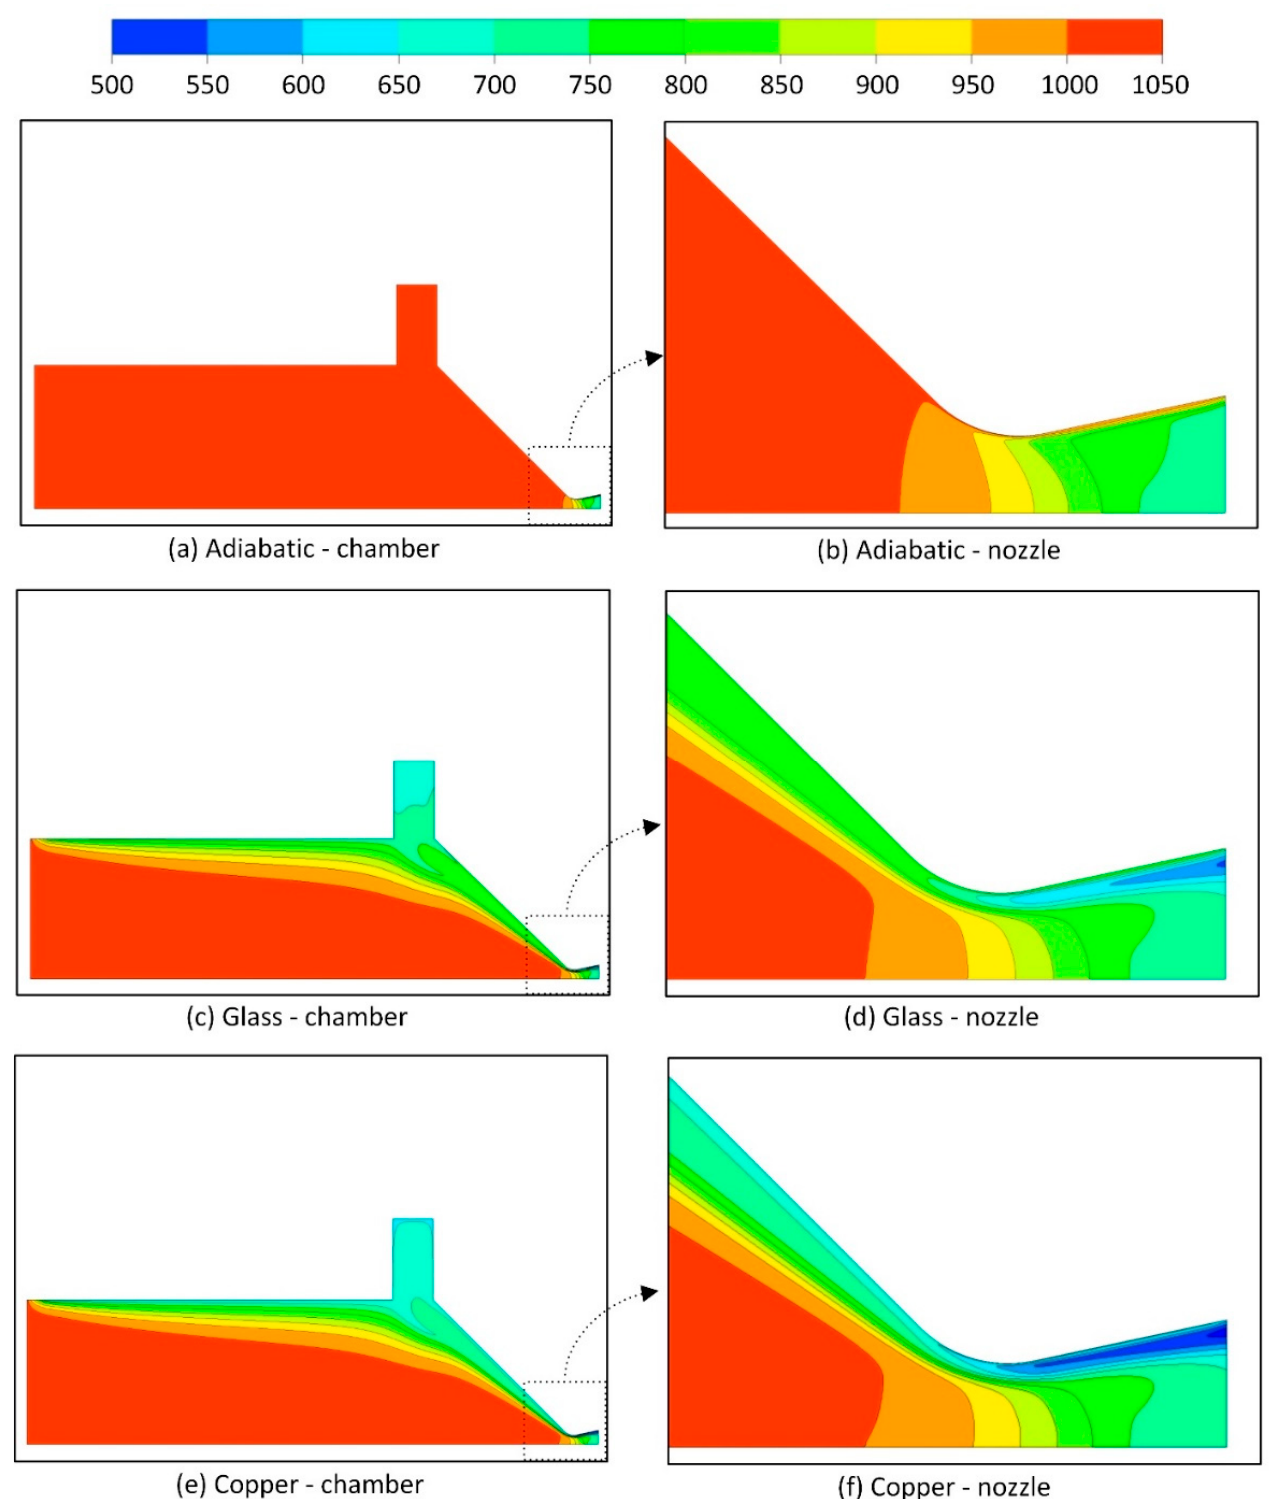
Figure 11. Temperature distribution on the symmetry plane in the fluid domain of the adiabatic, glass, and copper microthrusters, using 90 wt% hydrogen peroxide for the propellant (unit: K).